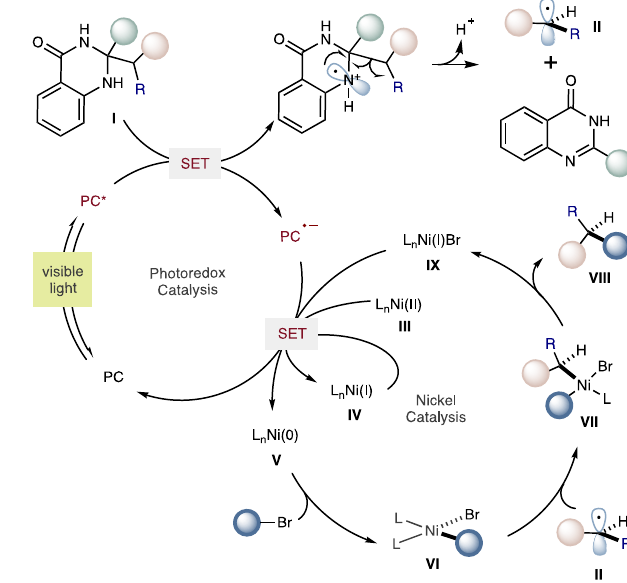
Fig. 7 Proposed mechanism. Proposed reaction pathway involves a reductive quenching photoredox cycle for the generation of alkyl radical from dihydroquinazolinone, which is captured by Ni(II) oxidative addition complexes to form Ni(III) species for subsequent cross-coupling by reductive elimination. The photoredox and nickel catalytic cycles are simultaneously closed by electron transfer from reduced photocatalyst to Ni(I) species generated post-reductive